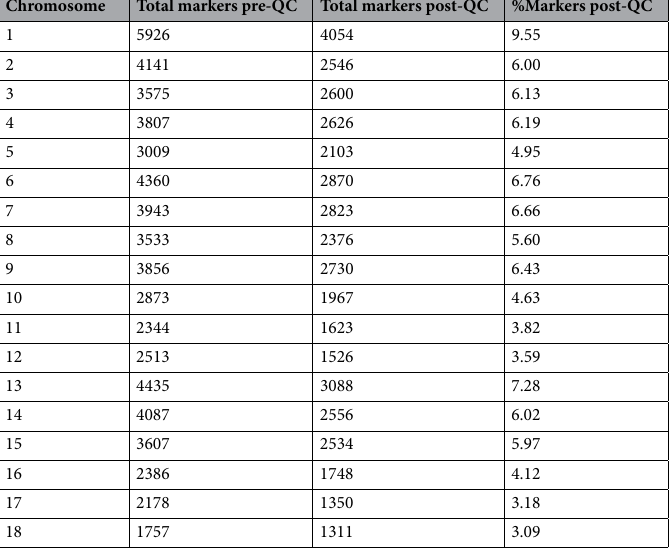
Table 4. Total number of SNPs before quality control (pre-QC), post quality control (post-QC) and the percentage of SNPs retained for each autosomal